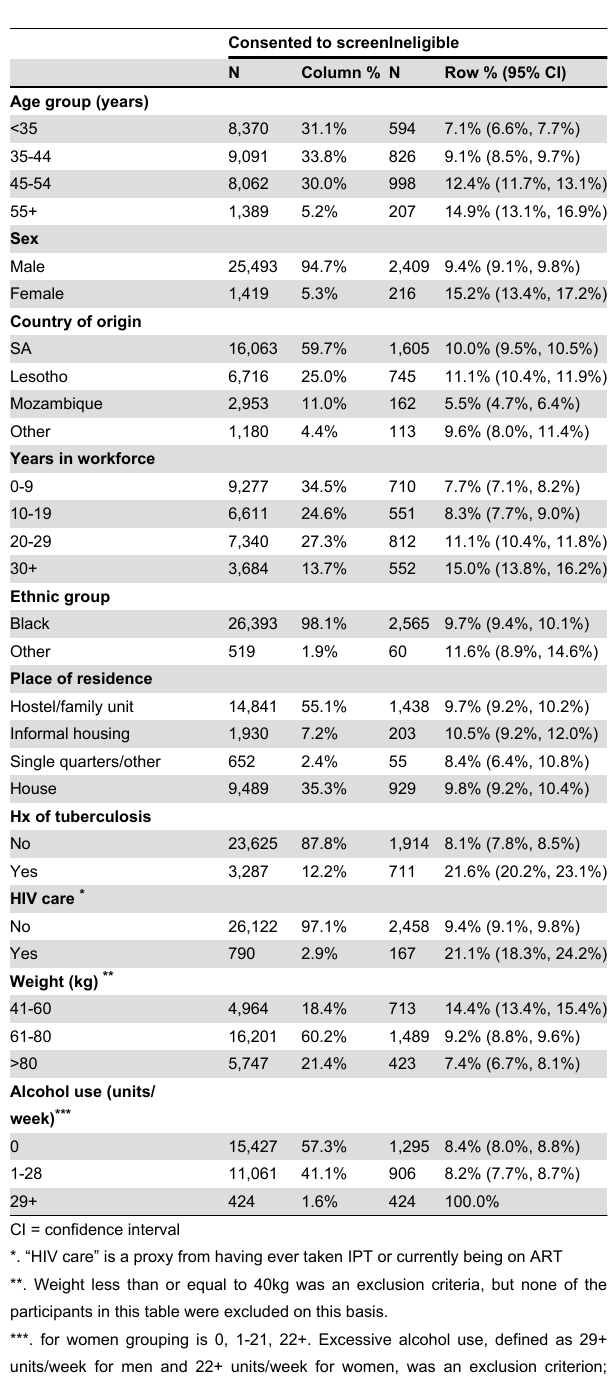
Table 2. Proportion ineligible for isoniazid preventive therapy in sub-groups